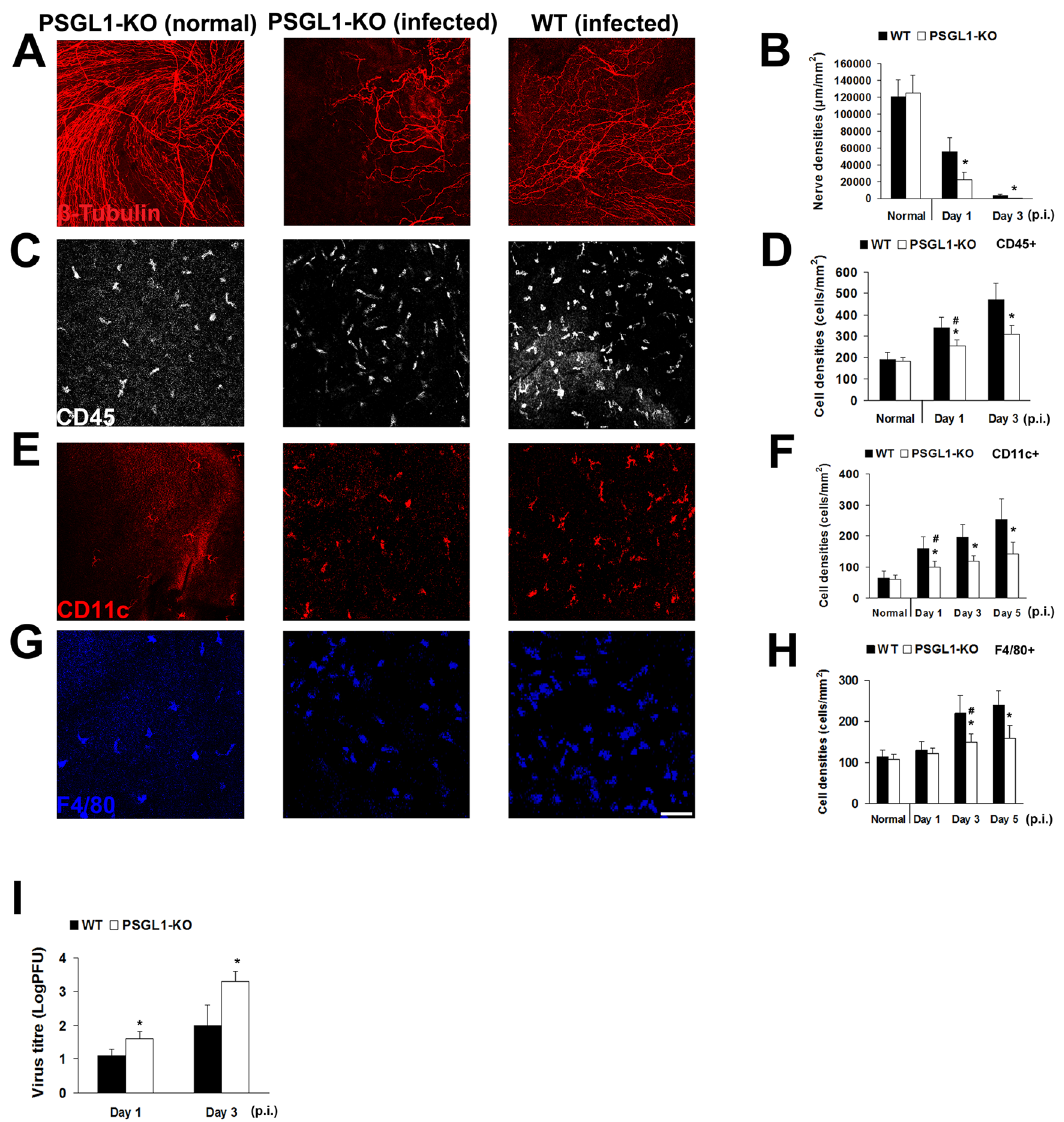
Fig 4. Corneal nerve damage in primary acute herpes simplex keratitis is due to viral proliferation and not corneal inflammation. A, B: Corneal nerve density was significantly decreased in PSGL1-KO mice as compared to WT mice after HSV-1 infection (n = 5/time point). C, D: The number of corneal inflammatory cells was significantly decreased in PSGL1-KO mice compared to WT mice after HSV infection (n = 5/time points). E, F: Corneal cDC density was significantly decreased in PSGL1-KO mice compared to WT mice after HSV infection. The increase of cDCs in PSGL-1 KO mice as compared to normal controls suggests potential differentiation from progenitor cells or proliferation (n = 5/time point). G, H: The number of corneal M Φ s was significantly decreased in PSGL1-KO mice as compared to WT mice after HSV infection (n = 5/time points). I : Corneal viral titers were significantly increased in PSGL1-KO mice compared with WT mice after HSV-1 infection (n = 5/time point). Each experiment was replicated three times. * p < 0.05 compared with WT; # p < 0.05 compared with normal (Student ’ s t-test, two-sided). Data are shown as mean ± SD. Scale bar: 100 μ